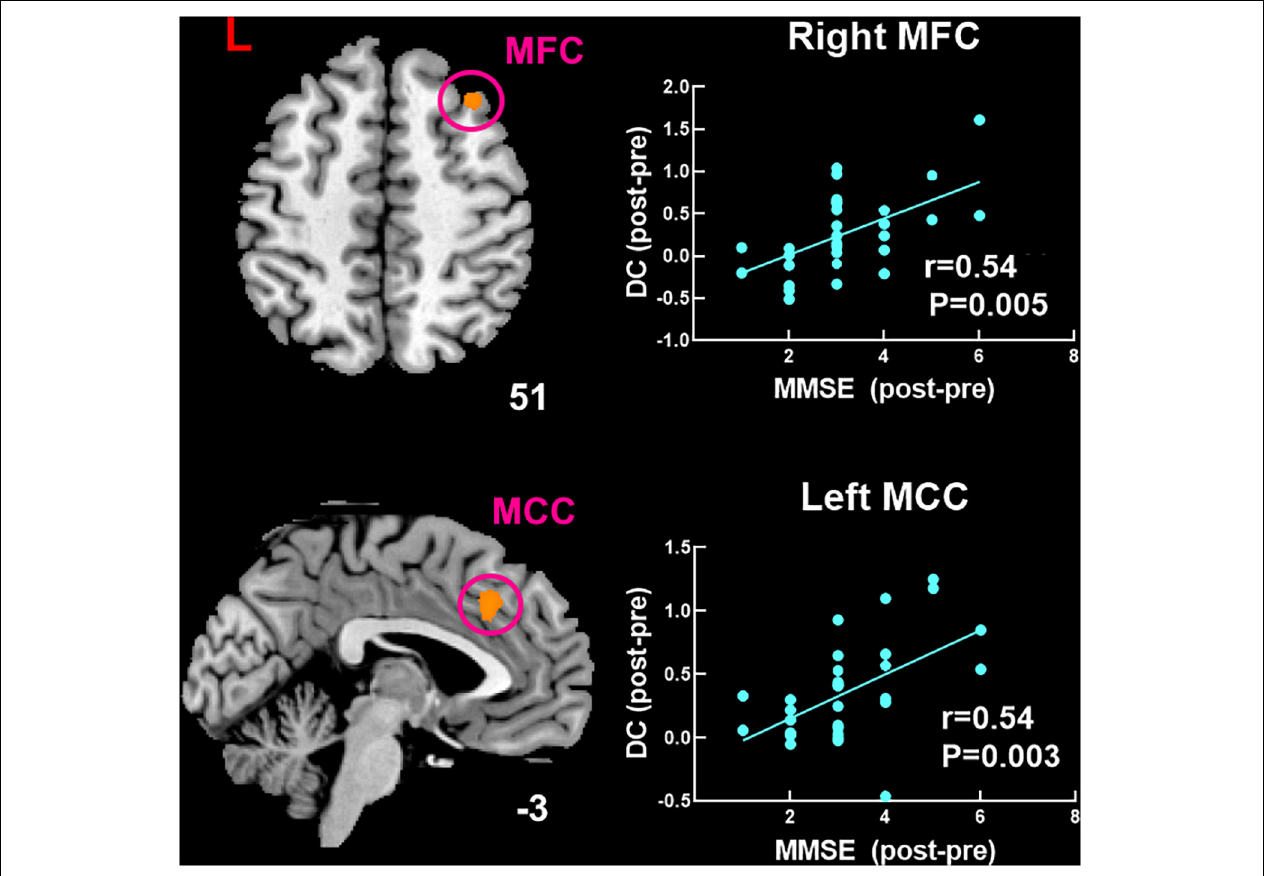
FIGURE 5 | Significant correlation between changed DC and changed MMSE score after moxibustion treatment in patients with MCI of TRUE group. DC, degree centrality; MoCA, Montreal Cognitive Assessment; MMSE, Mini-Mental State Examination; MFC, middle frontal cortex; MCC, middle cingulate